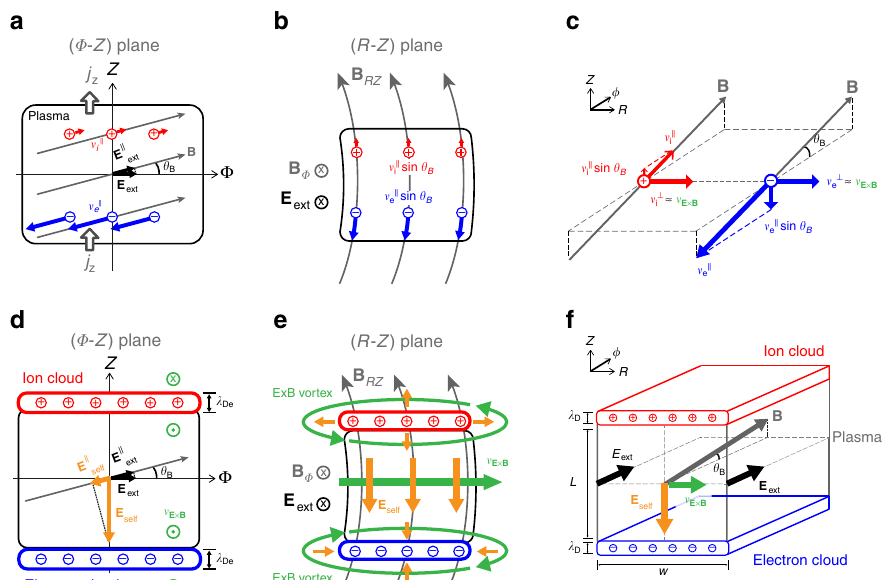
Fig. 3 Toroidally symmetric plasma model. Schematic diagrams of toroidally symmetric plasma model in ϕ -Z plane view ( a and d ), R-Z plane view ( b , e ), and three-dimensional view ( c , f ). a , b represent the guiding center motion of ions (red) and electrons (blue) in the low-density plasma ( n (cid:7) n n (cid:7) n ) where the self-electric fi eld effects are negligible. c to f depicts the self-electric fi elds (orange) and related ExB transports (green) in the high- crit ; ? , n (cid:8) n ). The magnitude of the magnetic fi eld pitch angle θ B in the order of 10 − 3 radians is exaggerated in the fi gure for density plasma ( n (cid:8) n crit ; k crit ; ?